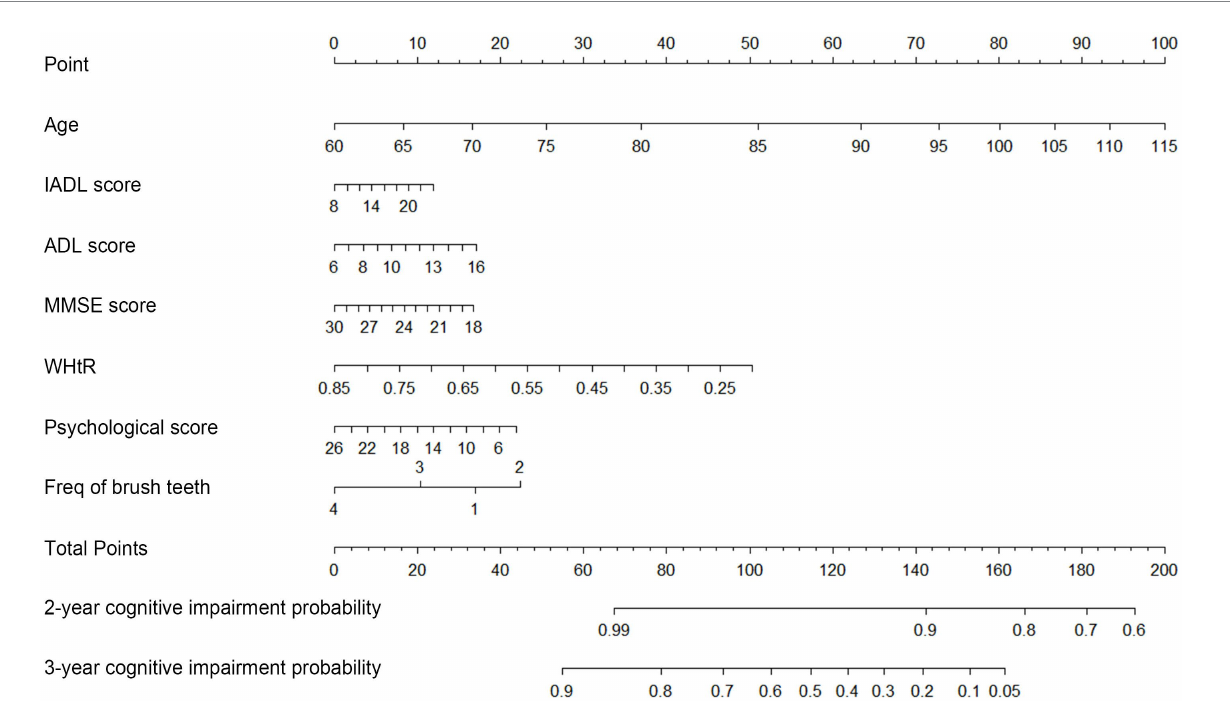
FIGURE 3 Nomogram of the Cox regression model with RCS for predicting the probability of cognitive impairment. To use the nomogram, points are produced for each factor by drawing a vertical line from the predictor’s value up to the points’ axis, and add the points from all of the factors. From the total points’ axis, a vertical line is then drawn to the 2-, and 3-year Risk axis, which yields a participant’s overall 2-, and 3-year cognitive impairment risk.